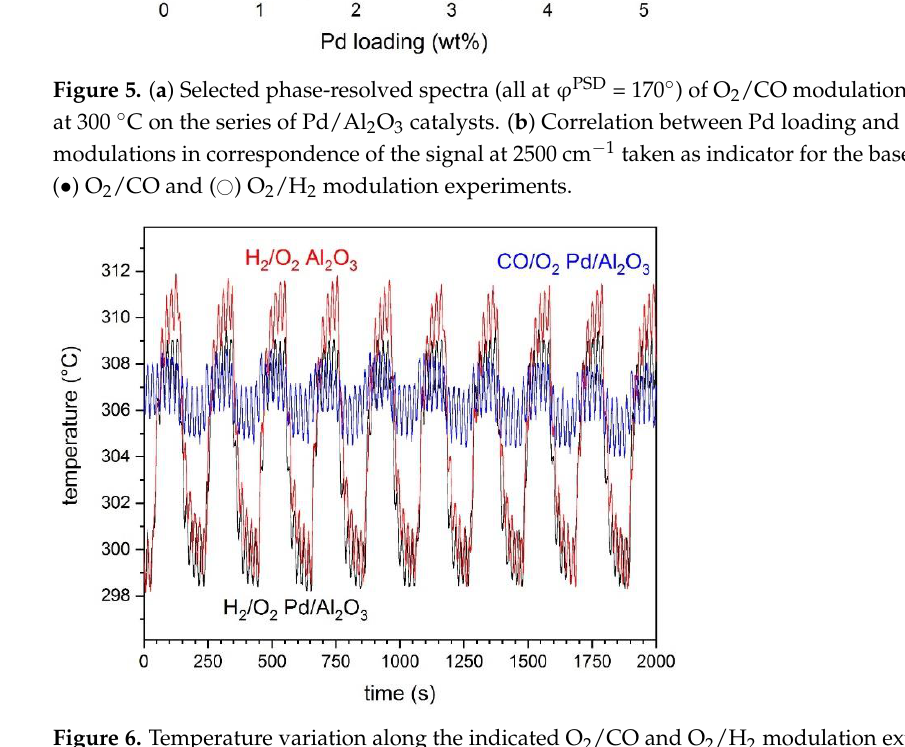
Figure 6. Temperature variation along the indicated O 2 /CO and O 2 /H 2 modulation experiments on Al 2 O 3 and 1 wt.% Pd/Al 2 O 3 Al 2 O 3 and 1 wt.% Pd/Al 2 O 3 .